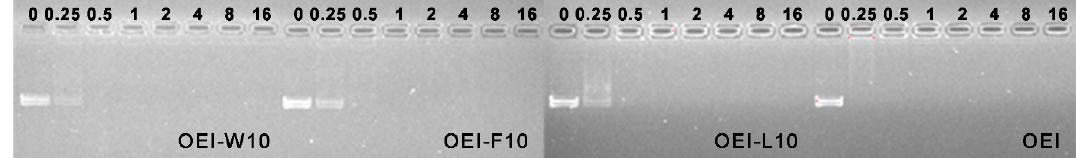
Figure 1. DNA condensation by OEI-AAs at various weight ratios evaluated by an agarose gel retardation assay.